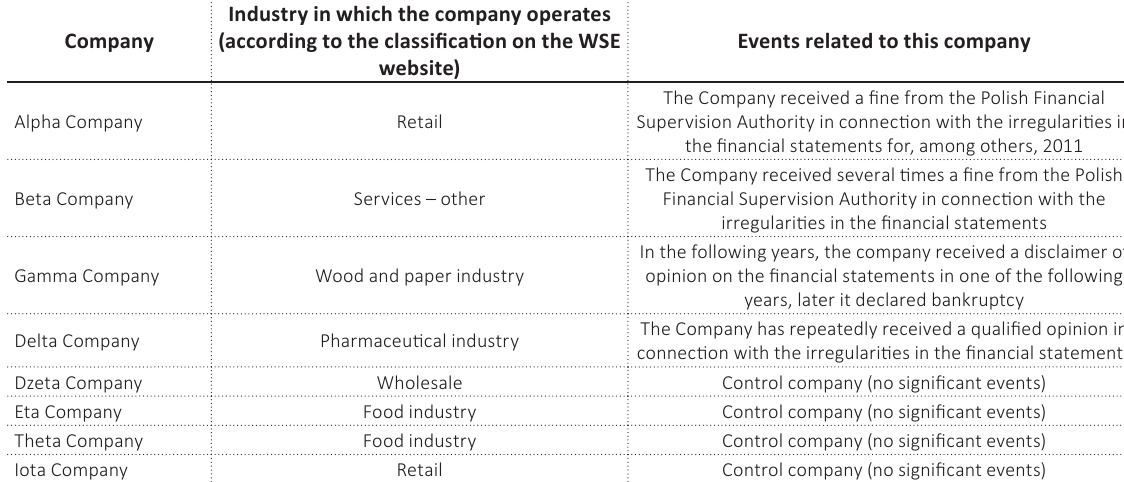
Table 2. Structure of companies tested with the Beneish model